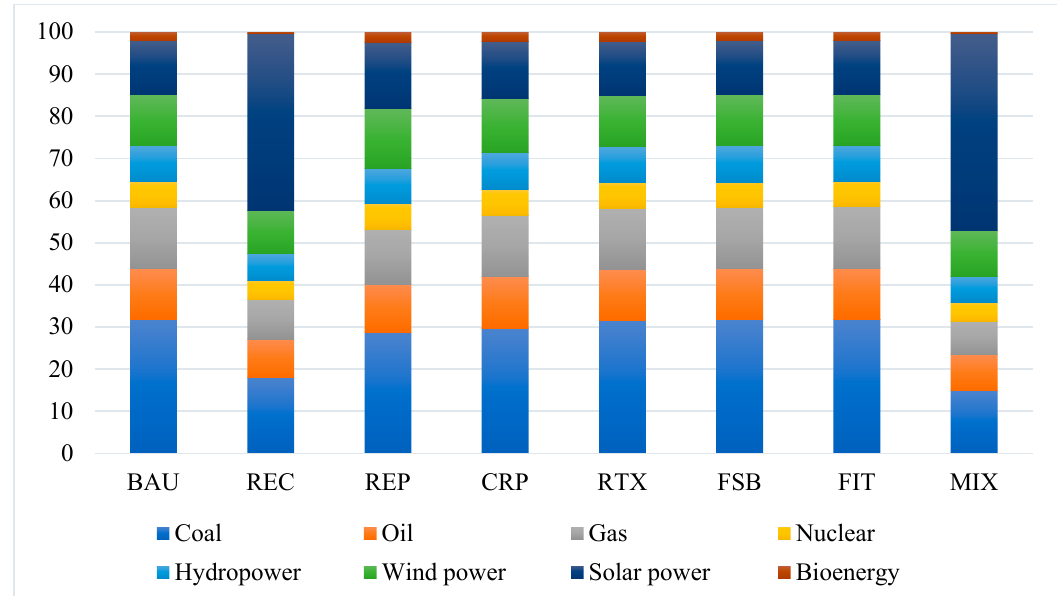
Figure 9. The structure of primary energy consumption in 2060 (%). Source: CHINAGEM model Figure 9. Thestructureofprimaryenergyconsumptionin2060(%). Source: CHINAGEMmodel simulation. Table 2. Primary energy consumption in 2060 (million tce).